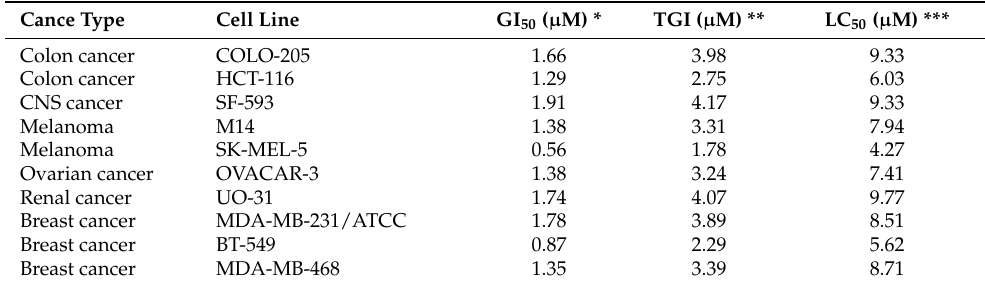
Table 2. Most remarkable GI 50 , TGI, and LC 50 values for selenourea 6c in different cancer cell lines. Results were obtained from the NCI-60 program. Full information for the 60 cancer cell lines is presented in the Supplementary